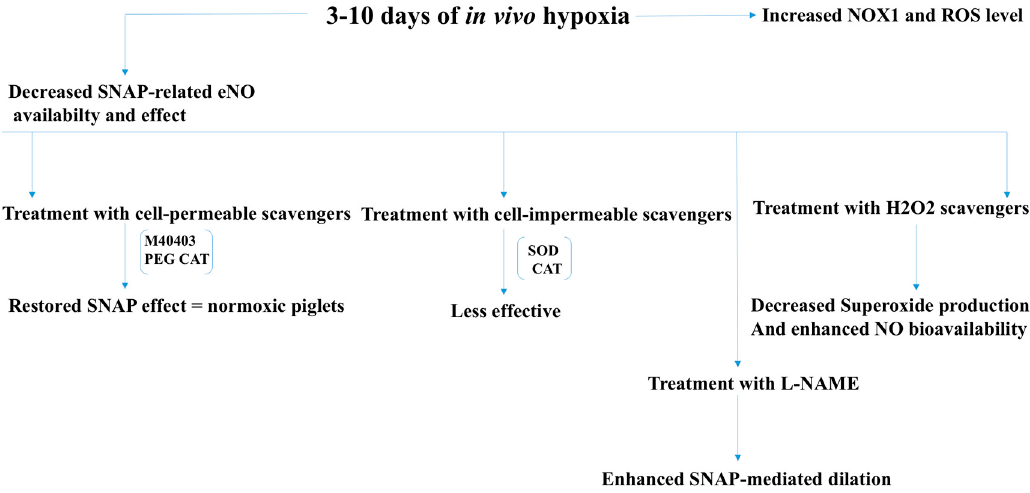
Figure 6. Increased NOX-derived ROS levels and eNOS uncoupling in hypoxic conditions give rise to pulmonary vasoconstriction resulting in pulmonary hypertension. ROS levels correlate with the level of hypoxia, which, in turn, play an important role in the pathogenesis and development of pulmonary hypertension. Combined treatment with superoxide-scavenger, H 2 O 2 -scavenger, and eNOS inhibitor (L-NAME) improve vasodilation in hypoxic conditions, suggesting that a hypoxia- induced increase in ROS levels involve both NOX activation and eNOS uncoupling. SNAP: Nitroso- N-acetyl-penicillamine; PEG CAT: Polyethylene glycol catalase; SOD: Superoxide dismutase; CAT: Catalase; NOX1: NADPH oxidase-1.